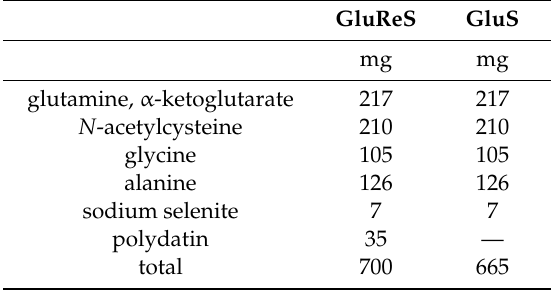
Table 2. The formulation of the two dietary